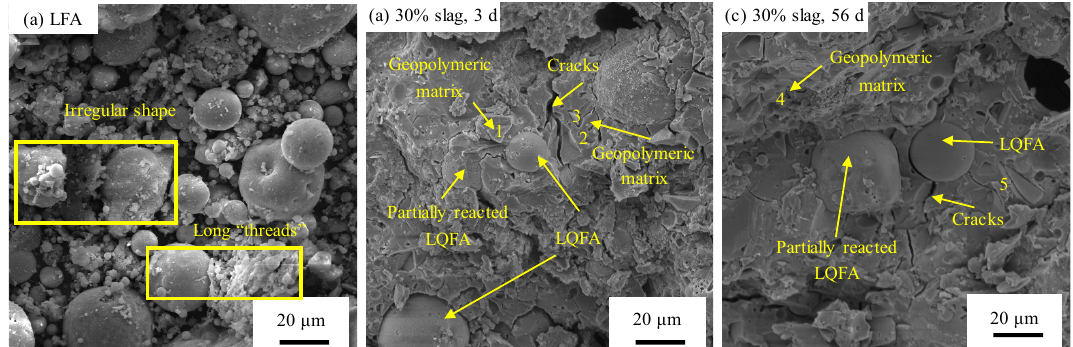
Figure 12. Scanning electron microscope (SEM) photographs of ( a ) LFA; ( b ) alkali-activated LFA-GGBS hybrid binders with 30% GGBS curing for 3 d; ( c ) alkali activate LFA-GGBS hybrid binders with 30% GGBS curing for 56 d. Table 4. The average content of different elements (%) for each point in Figure 12. Elements